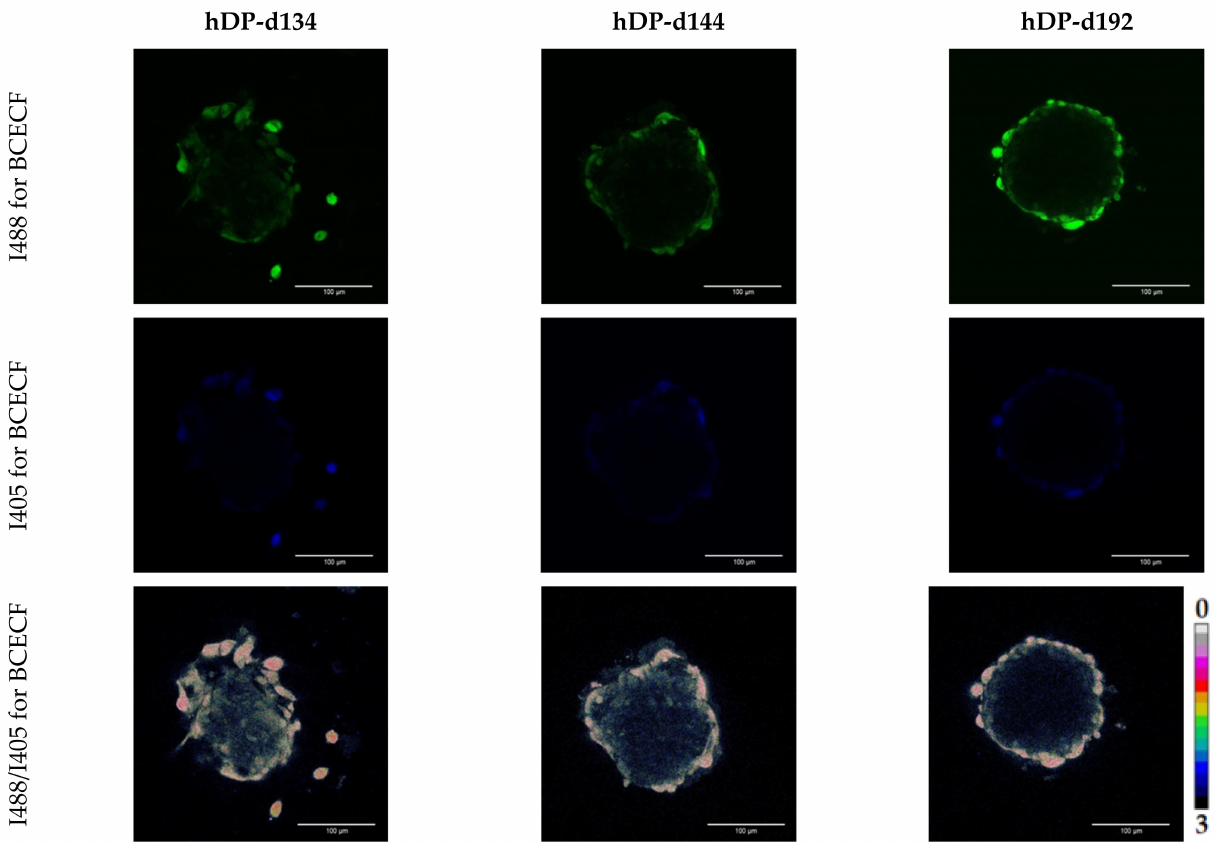
Figure 10. Analysis of the intracellular pH hDP spheroids: Images of the fluorescence intensity of BCECF when excited at a wavelength of 488 nm and 405 nm and images of the fluorescence intensity ratio I488/I405 in hDP spheroids. Excitation of BCECF fluorescence at 488 and 405 nm, fluorescence detection at 500–550 nm. Images size is 213 × 213 µ m, the scale length in all pictures is 100 µ